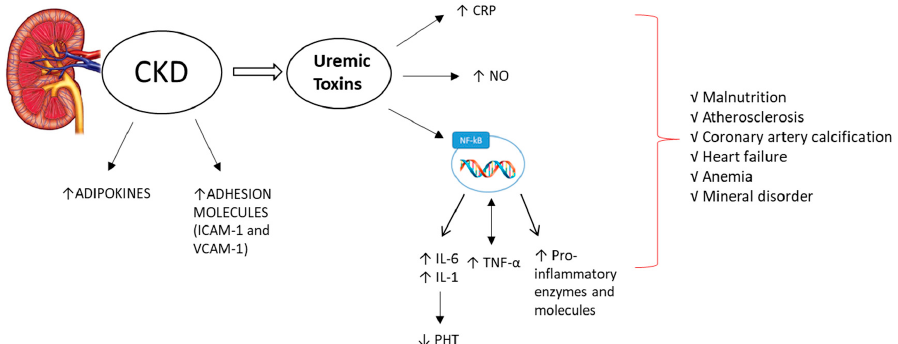
Figure 1. During chronic kidney disease (CKD), increases ( ↑ ) in adipokines and in adhesion proteins (such as ICAM-1 and VCAM-1) are observed. Uremic toxins play a very important role in the onset and progression of the inflammatory state, by increasing C-reactive protein (CRP), nitric oxide (NO) and a marked activation of the nuclear factor kappa-light-chain-enhancer of activated B cells (NF- κ B), which lead to increased levels of pro-inflammatory cytokines, such as interleukin-6 and -1 (IL-6, IL-1). These also suppress ( ↓ ) parathyroid hormone (PTH) secretion, as well as enhancing the levels of tumor necrosis factor-